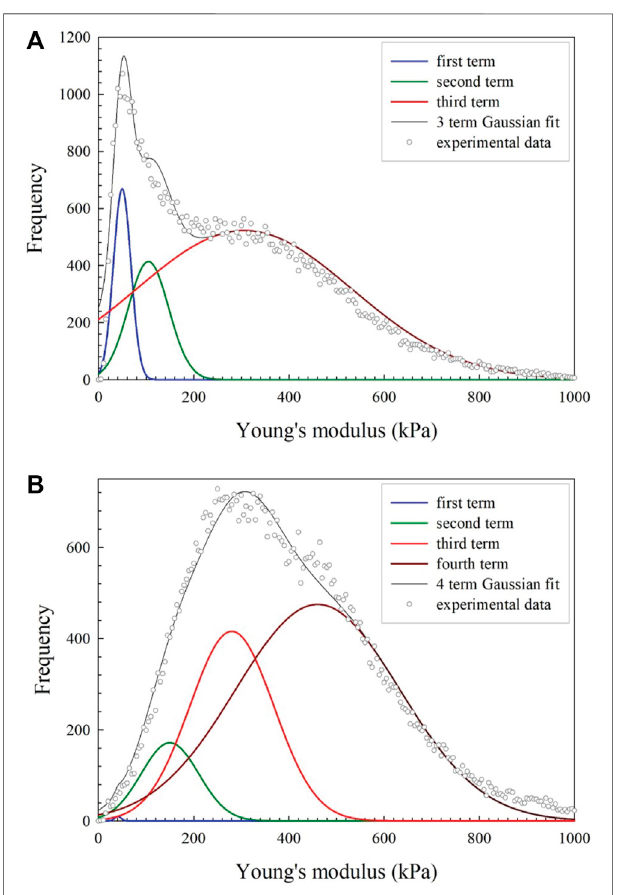
FIGURE2| ExamplesofthreeandfourtermGaussianmodels fi tto (A) a simpler and more clearly de fi ned frequency set which was used to set the bound for (B) , a more complicated and convoluted frequency set.